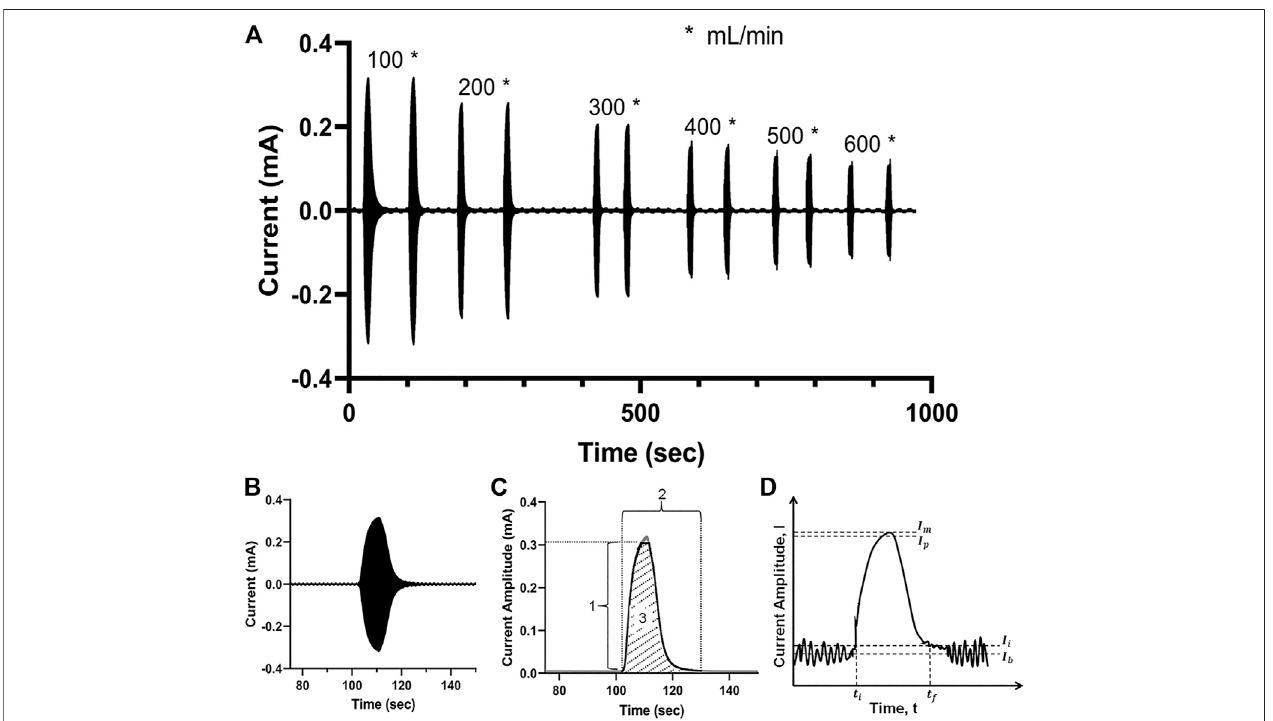
FIGURE 3 | (A) Measured current signal over time for a pair of saline injections at each of six fl ow rates for water — from 100 to 600 ml/min. (B) The measured currentsignal after asingle injection; thedensely packed sinusoidal ACsignal appears asa fi lledcurve; (C) the crestofthe current signal amplitude is extracted to obtain the electrodilution curve (solid black line); 1: Δ current amplitude; 2: total time; 3: Δ total charge. (D) The electrodilution metrics are determined from the electrodilution curve shown (baseline noise exaggerated for illustration purposes). All measurements were carried out at AC voltammetry settings of 0.1 V pk and 0.5